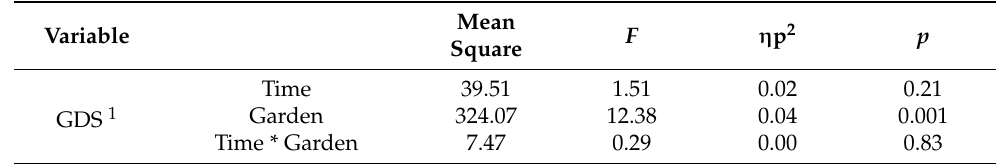
Table 2. Two-way ANOVA results (GDS for each measuring point).